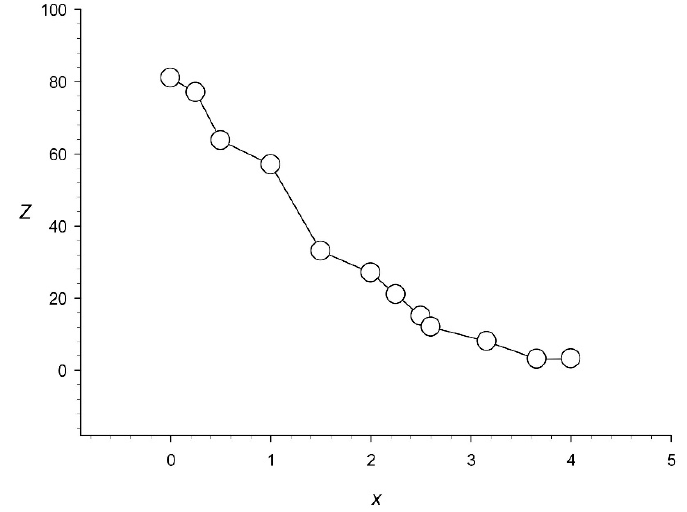
Figure 1. Dependence of statistical significance Z on the average number of substitutions per nucleotide x between any two repeats. A total of 50 insertions and 50 deletions of 1 nt were made in an artificial sequence of 3000 nt, which contained 100 repeats of 30 nt each.